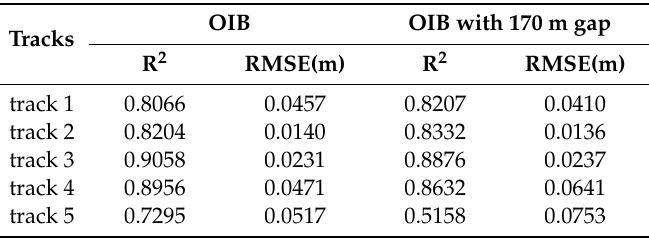
Figure 10. R 2 ( a ) and RMSE (m) ( b ) for all tracks of ATM L2 170 m gap data between local sea level retrievals from the lowest elevation method and retrievals from the DMS method (ground truth) at 7 segment length scales: 1, 5, 10, 15, 20, 25, and 50 km, for 9 percentage scales: 0.1%, 0.5%, 1%, 1.5%, 2%, 2.5%, 3%, 3.5%, and 4%. Table 2. Comparison of the indices R 2 and RMSE(m) for each track with a 1 km segment length and 0.1% scale between OIB with and without a 170 m gap.